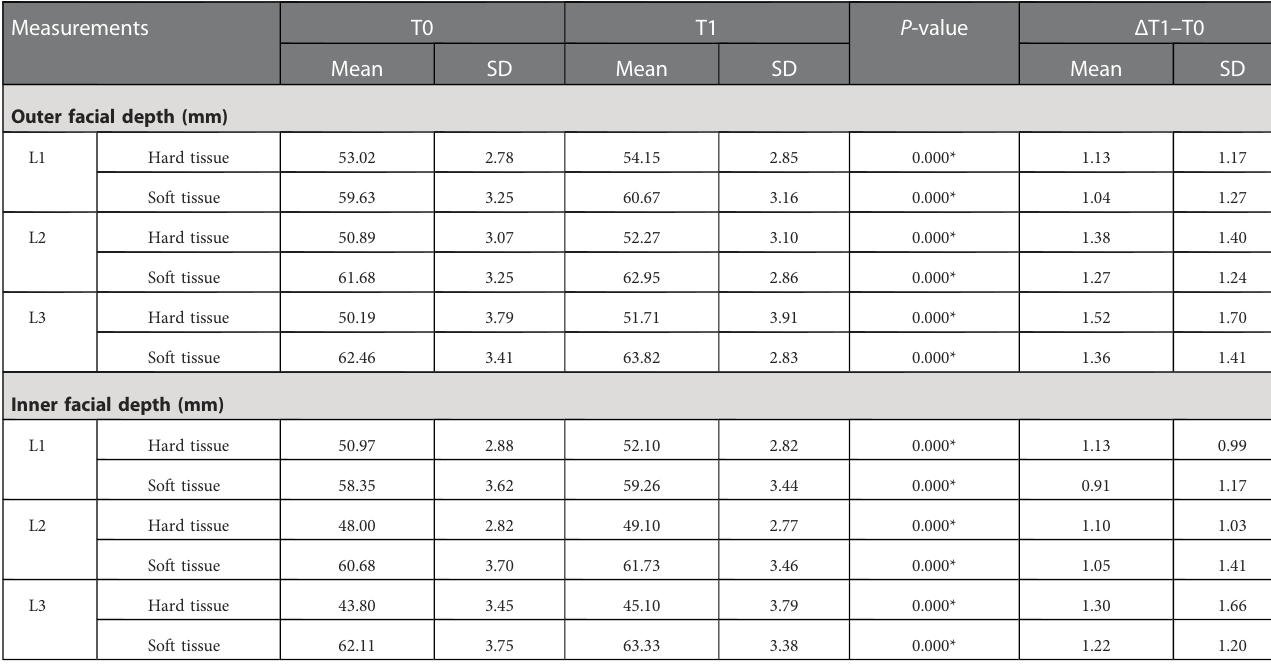
TABLE 1 Comparison of the mid-facial depth changes between T0 and T1. Measurements